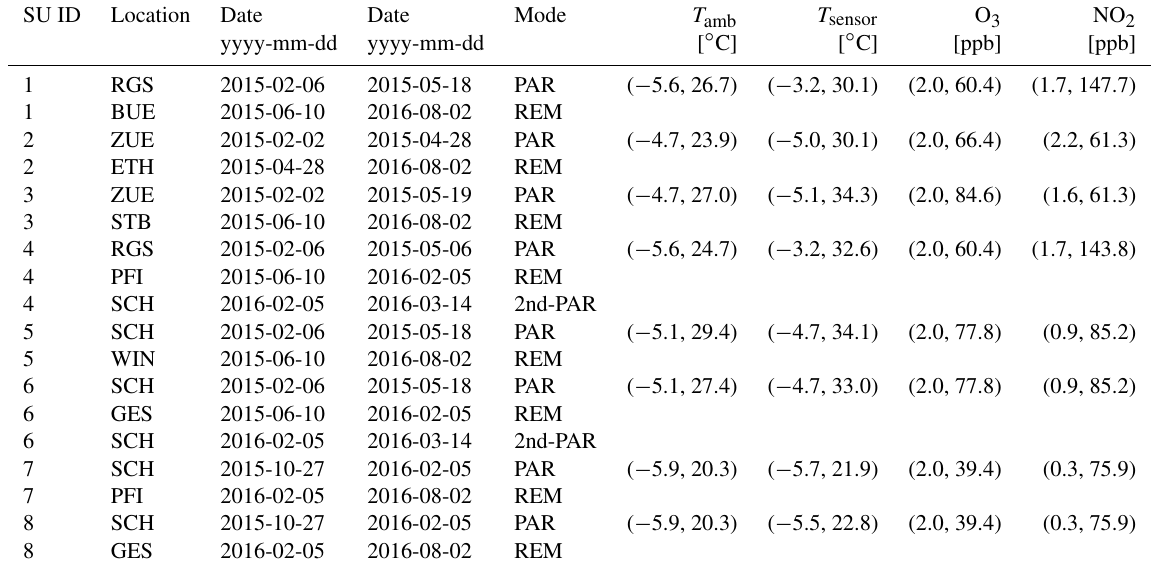
Table 3. Operation of the sensor units (SU). PAR denotes the calibration of sensors of the SU while they were co-located with instruments from AQM sites, 2nd-PAR denotes the inspection of the sensor performance after operation time (co-location with instruments from AQM sites), and REM denotes the operation of the SUs at a sensor network location. T amb , T sensor , O 3 and NO 2 indicate the range of ambient temperature measured by instruments from the AQM site, temperature inside the SU and ozone and nitrogen dioxide, respectively, during the calibration periods. SU006 is equipped with Alphasense NO 2 B4 sensors, while the others are equipped with Alphasense NO 2 B42F